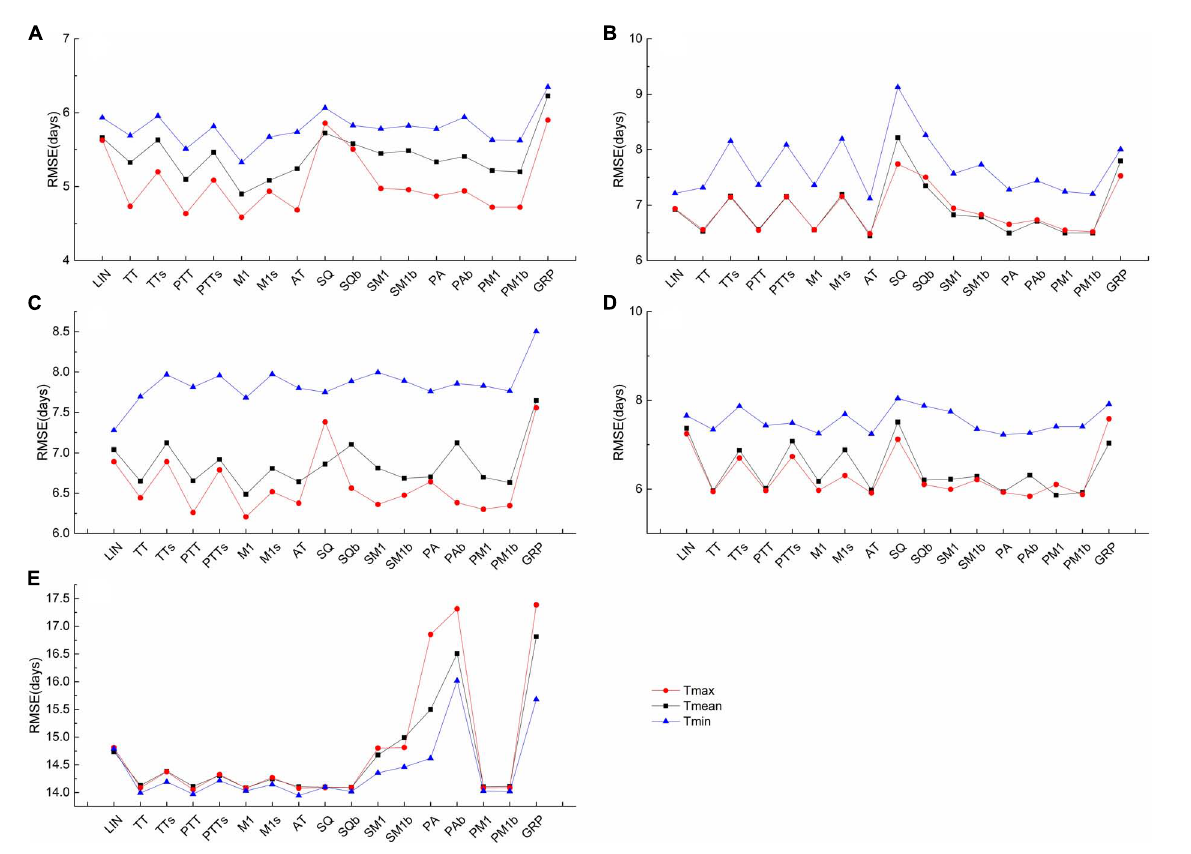
FIGURE5 RMSE of the satellite-derived start of the growing season (SOS) versus the simulated SOS for the 17 models parameterized using Tmax, Tmean, and Tmin for five vegetation types: (A) deciduous needleleaf forest (DNF), (B) mixed forest (MF), (C) open shrublands (OSL), (D) woody savannas (WS), and (E) grasslands (GL). Model abbreviations: see Table 2 . The RMSEs were estimated from the SOSs of the validation